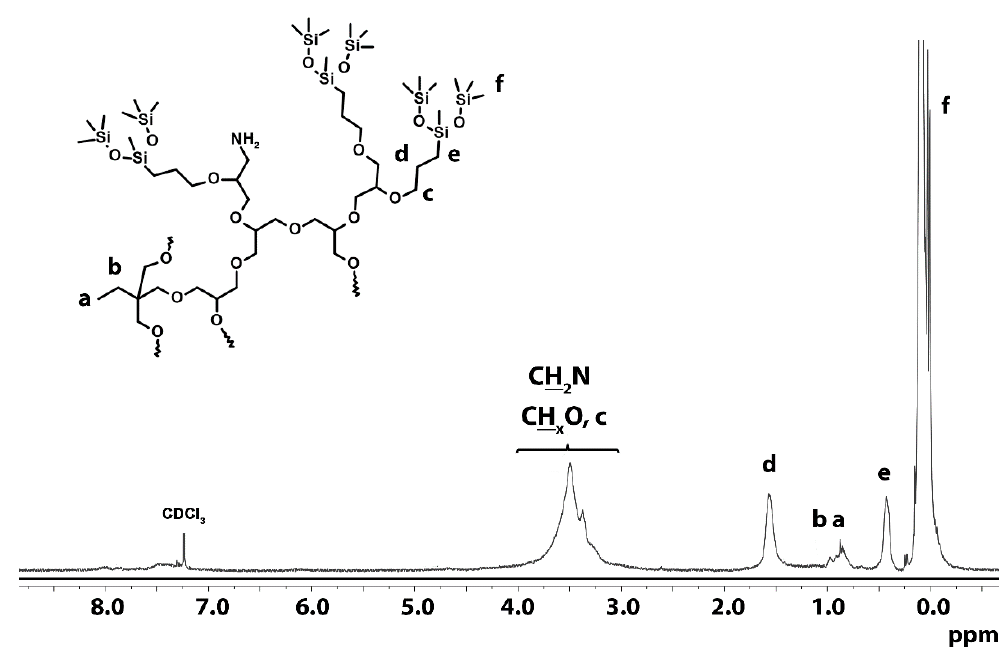
Figure 6. 1 H NMR (CDCl 3 , 400 MHz) spectrum of 4b copolymer.